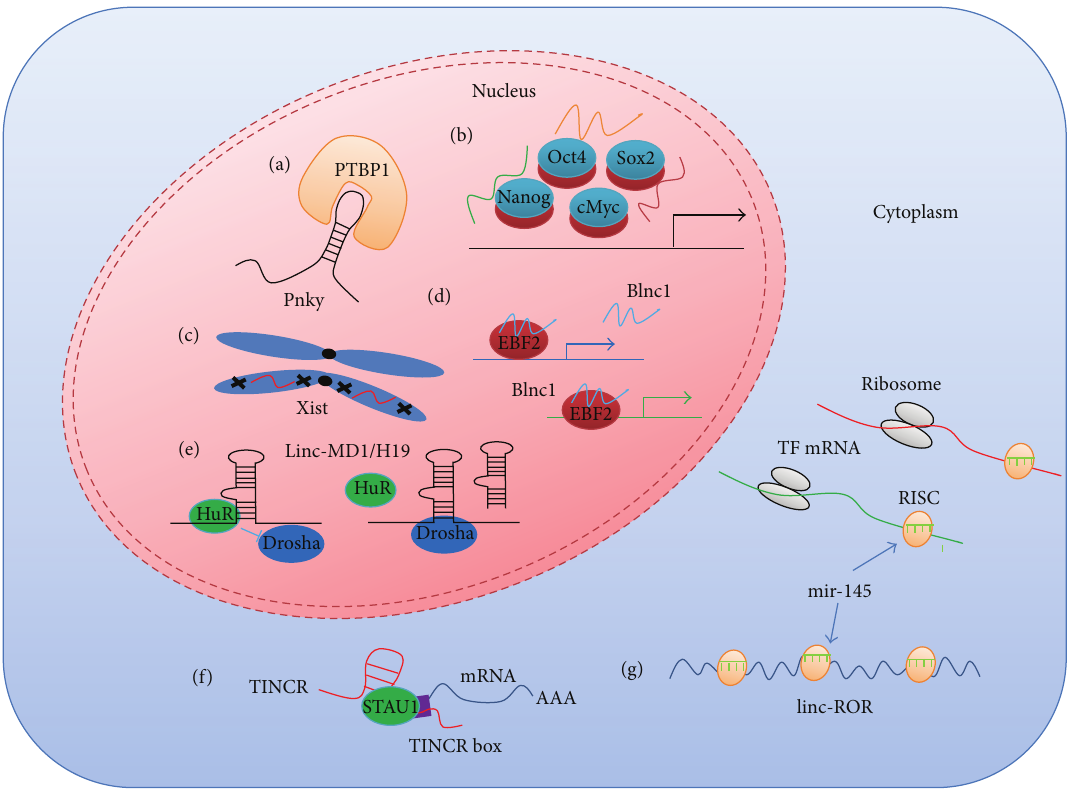
Figure 1: Some known functional mechanisms of lncRNAs in stem cells. (a) Pnky localizes to the nucleus and interacts with the mRNA splicing regulator PTBP1 to regulate splicing of key transcripts; (b) some lncRNAs serve as cofactors of key transcription factors (TF) to regulate gene transcription; (c) Xist as an epigenetic regulator of X chromosome inactivation plays roles in female ESCs and iPSCs; (d) Blnc1 is activated by EBF2 and functions as a coactivator of EBF2; (e) linc-MD1 is the primary transcript of miR-133b and H19 is the primary transcript of miR-675, and the Drosha processing of both is regulated by HuR; (f) TINCR interacts with STAU1 and multiple mRNAs via an RNA motif called TINCR box; (g) linc-ROR functions as a mir-145